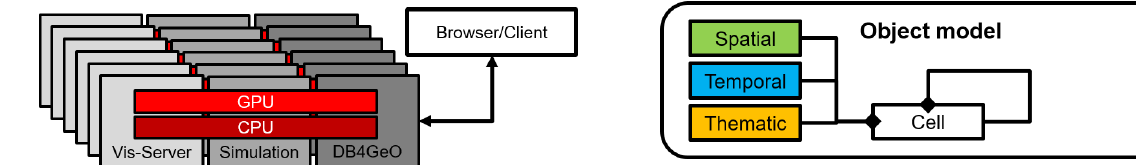
Figure 1. DB4GeO’s approach to run parallel to the In-Situ framework of Paraview